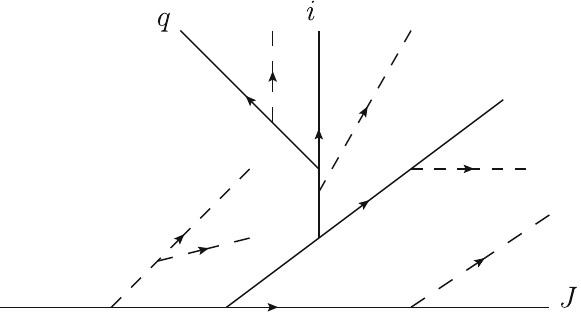
Fig. 8 An illustration of a branch containing hard parton J . The sub- branch for parton q contains the partons with solid lines, these form parton q ’s ‘parental chain’. Partons with dashed lines are in J ’s branch but are not in q ’s sub-branch. The sub-branch length is the number of partons in a sub-branch: parton q ’s sub-branch has a length 4 whilst parton i ’s sub-branch has a length